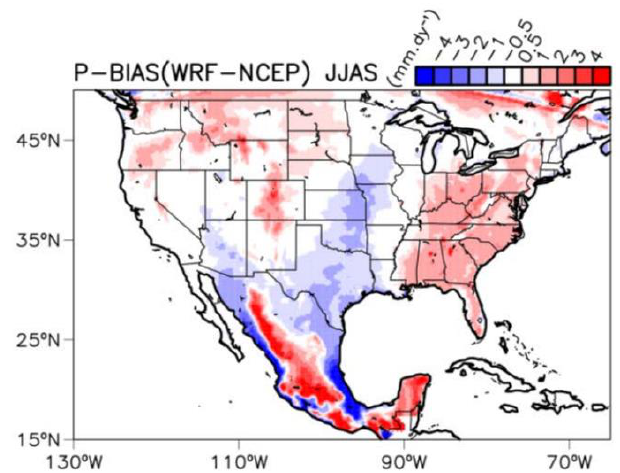
Figure 13. Average warm season (JJAS) precipitation bias (mm day −1 ) for WRF-NCEP (P-BIAS = RCM minus P-NOAA observation). Red (blue) colors indicate precipitation overestimation (underestimation) by WRF. From [21] © American Meteorological Society. Used with permission.